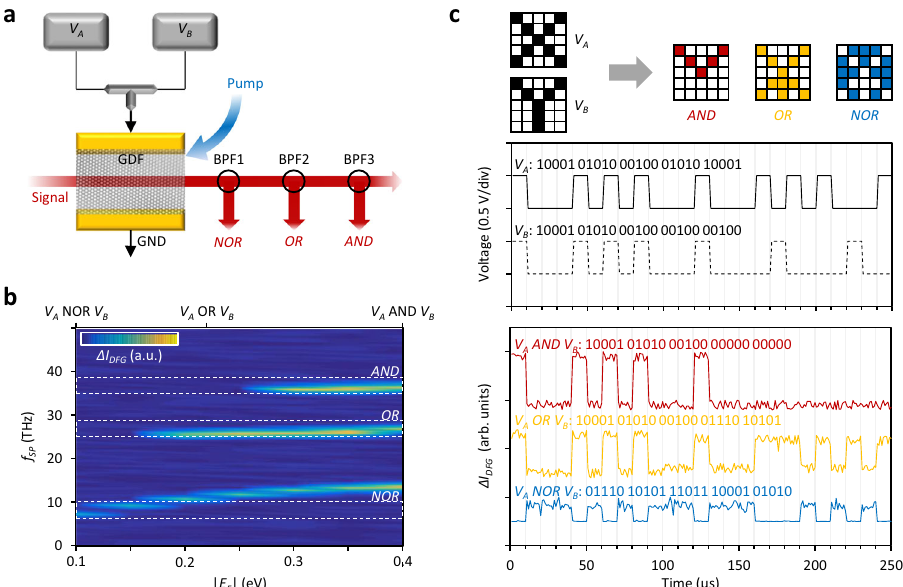
Fig. 4 Electro-optic logic operations and gates. a Schematic design of the setup to obtain the logic outputs NOR, OR and AND using three bandpass fi lters (BPFs). Here V A and V B are two independent digital signals used to tune the graphene | E F | . b Results of the fi ltering in the | E F | − f sp space for the frequencies 7.5, 27 and 36 THz selected by the three BPFs and corresponding to the three logic operation of NOR, OR, AND. Dashed boxes: fi ltering bands of the three BPFs. c Example of logic operations measured at the outputs of the three BPFs, here the black curves plot the amplitudes of V A and V B , while red, yellow and blue curves show the output of the AND, OR, NOR